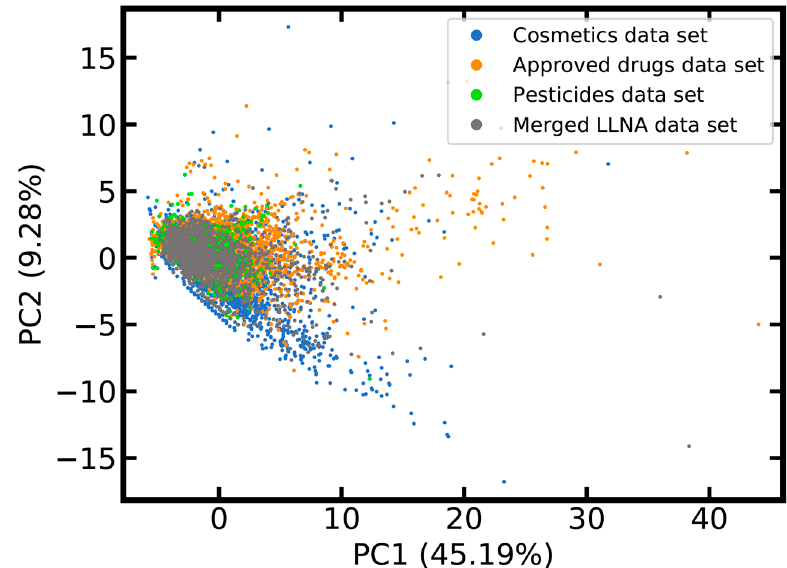
Figure 1. Score plot comparing the chemical space of compounds of the merged LLNA data set, cosmetics, approved drugs and pesticides. The plot is derived from a principal component analysis (PCA) based on 53 intuitive and physically meaningful molecular descriptors such as molecular weight and clogP (see Methods and Table S1 for details). Data points located in the lower parts of the PCA score plot are primarily cosmetics with long aliphatic and often halogenated chains; towards the top right corner of the diagram these are primarily large drug molecules with strong aromatic components. The variance explained by the first two principal components is reported in the axis titles. Four compounds of the cosmetics reference set and eight compounds of the approved drugs reference set are not shown because they are off the chosen limits of the plot (these are complex and large molecules, with a molecular weight of 2800 Da and higher).